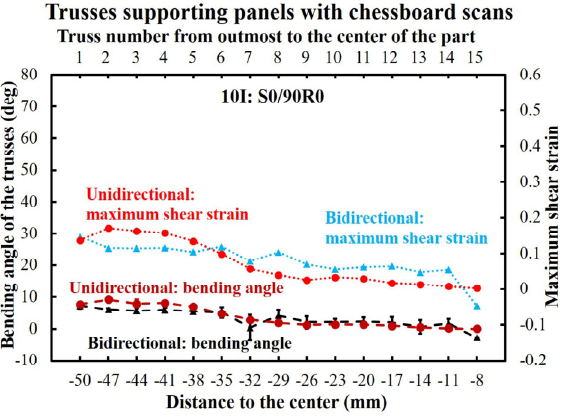
Figure 18. The bending angle and maximum shear strain (derived from maximum bending angle) of the chessboard printing.